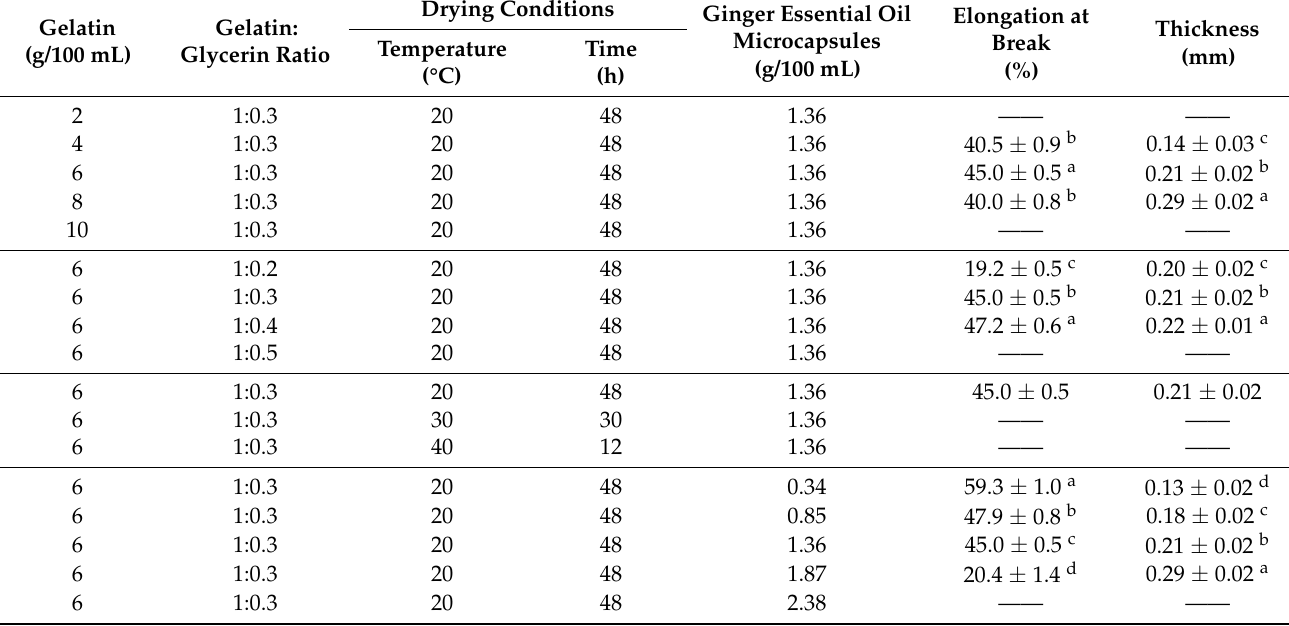
Table 1. Optimization of preparation conditions of ginger essential oil microcapsules